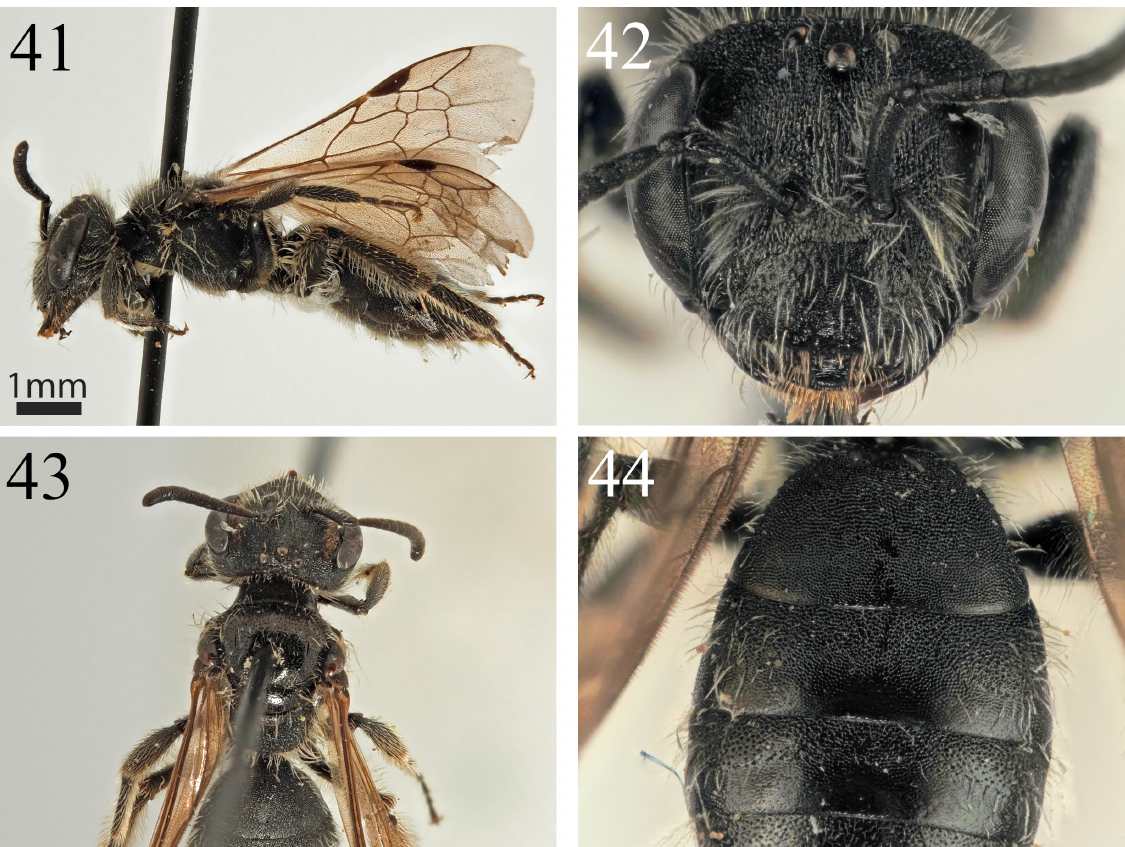
Figs 41–44. Andrena elam Wood sp. nov., ♀ (OÖLM). 41 . Profile. 42 . Face. 43 . Dorsum. 44 .